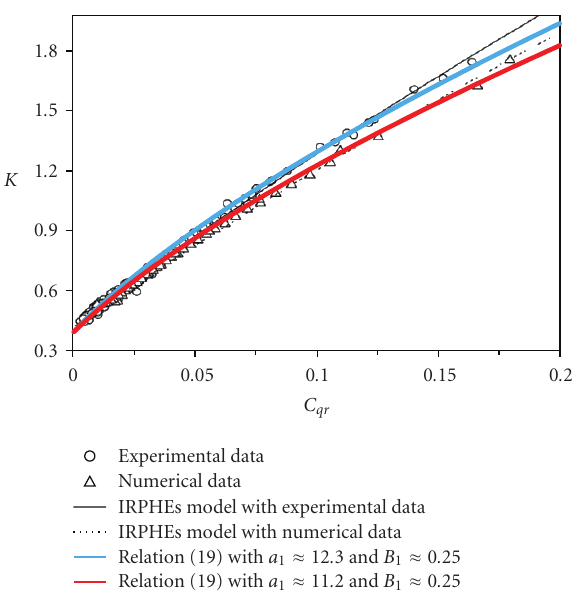
Figure 10: Core swirl ratio distribution deduced from (19). Comparison with experimental and numerical results from Poncet [17].